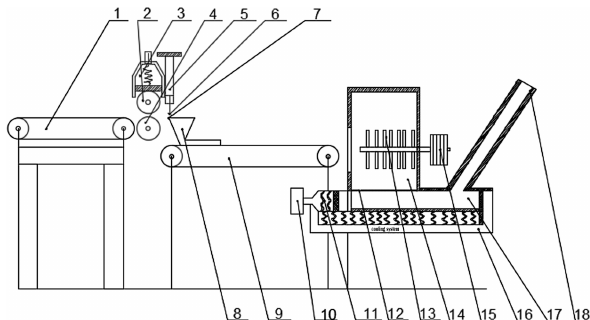
Figure 1. Overall structure diagram of the crushing system.